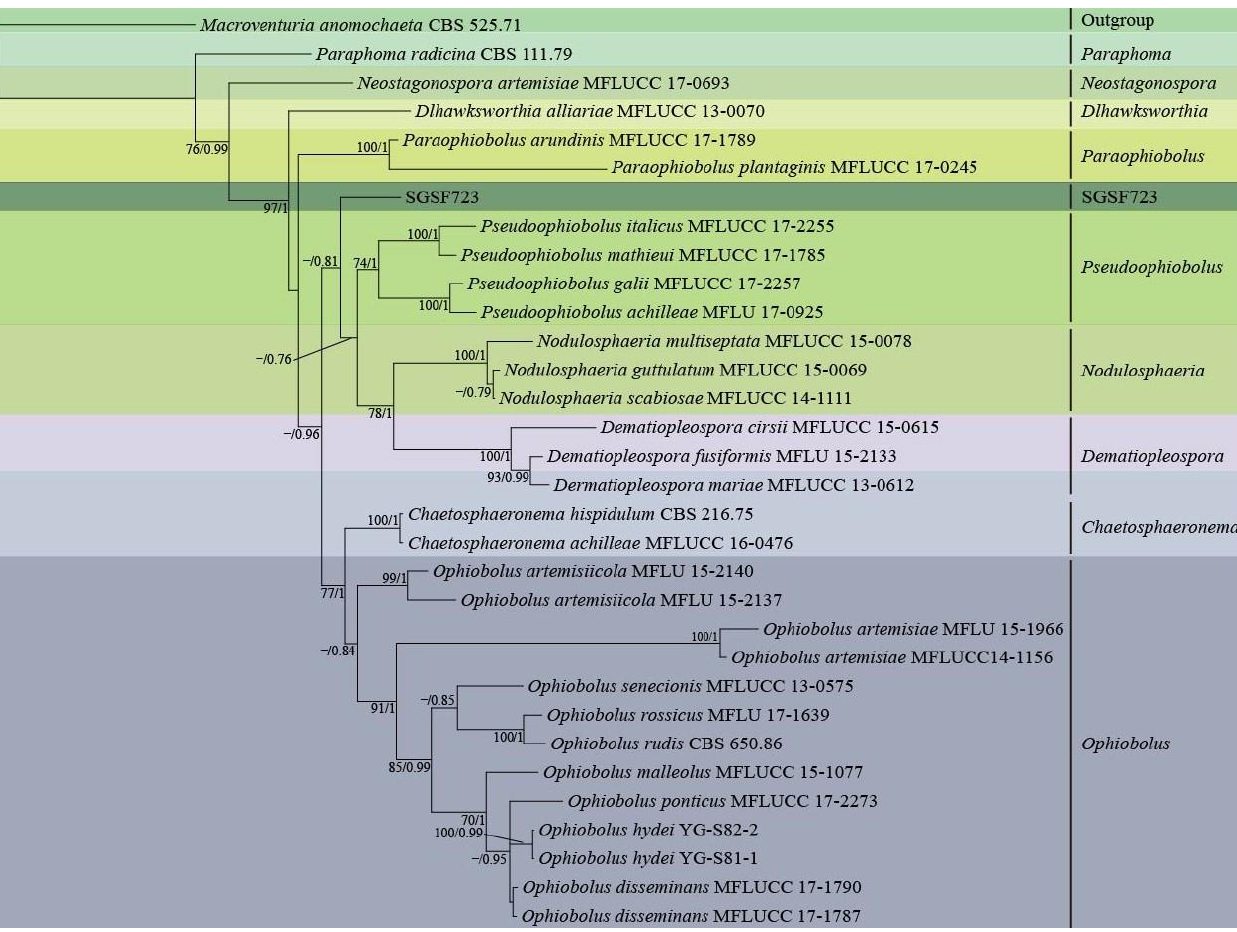
Figure 2. Phylogenetic analysis of strain SGSF723 on ITS, LSU, SSU, and TEF by RAxML and MrBayes; Bootstrap support values ≥ 70% and bayesian posterior probability scores ≥ 0.7 are indicated along branches.